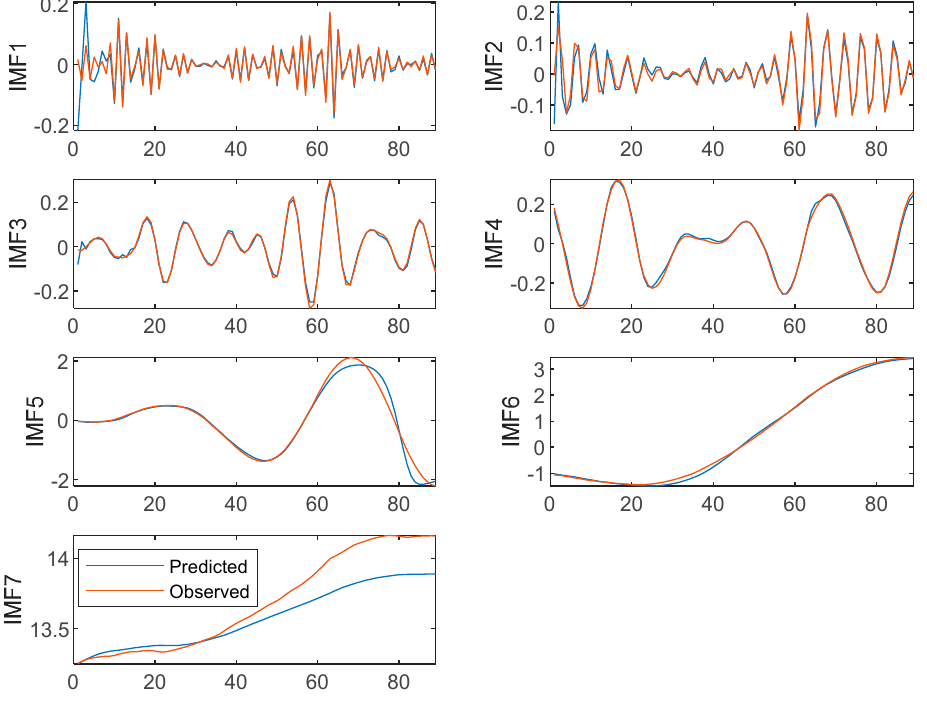
Figure 8. Results of fitting each IMF component to the carp price dataset.